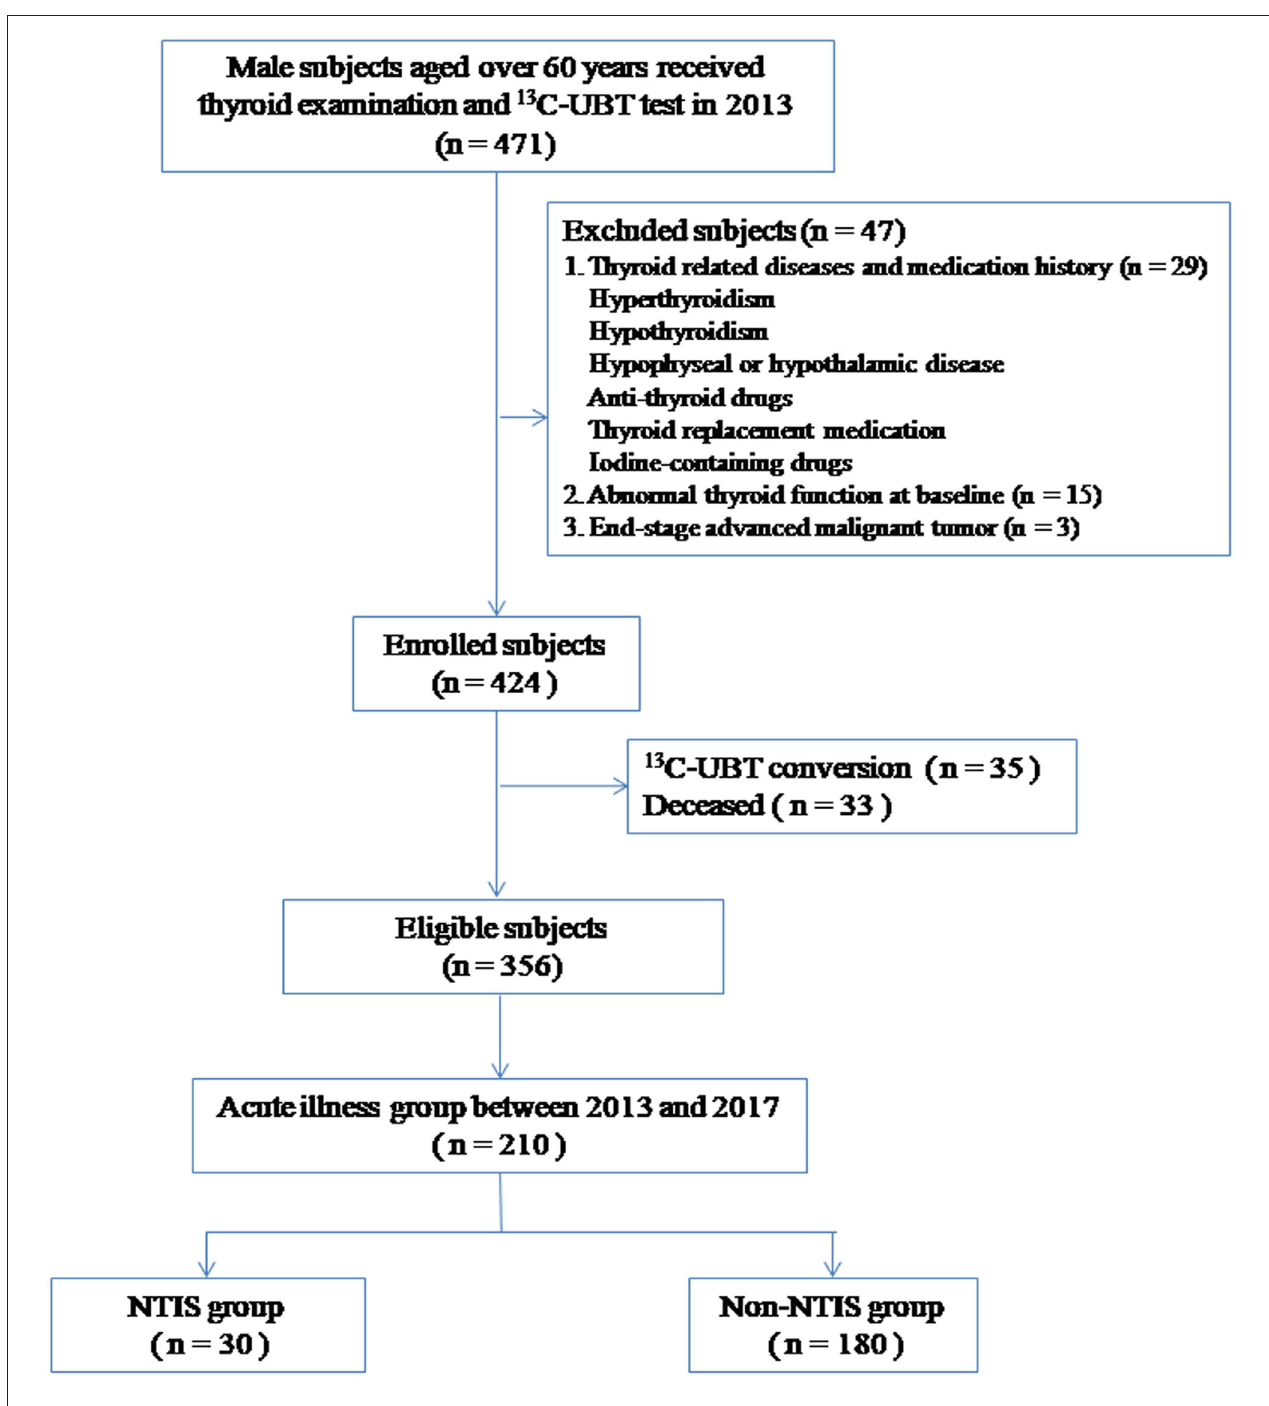
FIGURE 1 | Participant’s recruitment flow diagram.